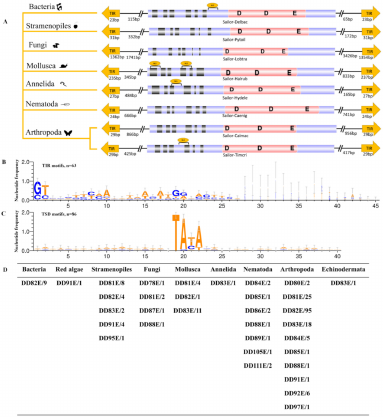
Figure 4. Schematic representation of the structure of Sailor transposons. ( A ) Structural orga- nization of Sailor elements. The yellow arrows represent Sailor , the black rectangles represent HTH motifs, the yellow circle represents the NLS, the pink rectangles represent the catalytic do- mains, and the blue regions represent transposases ( Sailo r-Delbac ( Deltaproteobacteria bacterium ), Sailor -Phyoil ( Pythium oligandrum ), Sailor -Lobtra ( Lobosporangium transversale ), Sailor -Halrub ( Haliotis rubra ), Sailor -Hydele ( Hydroides elegans ), Sailor -Caenig ( Caenorhabditis nigoni ), Sailor -Calmac ( Callosobruchus maculatus ), Sailor -Timcri ( Timema cristinae )). ( B ) The WebLogo server (http://weblogo. berkeley.edu/logo.cgi/, accessed on 15 September 2021) was used to create the logo representation of the TIR ( ≤ 45 bp) sequences. The value 2 (log2 4) on the y axis stands for maximum possible frequency. ( C ) The WebLogo server (http://weblogo.berkeley.edu/logo.cgi/, accessed on 25 April 2021) was used to create the logo representation of the TSD sequences. ( D ) The table shows the situation of different kingdoms of DDxE, with the number placed after the slash representing the number of DDxE.